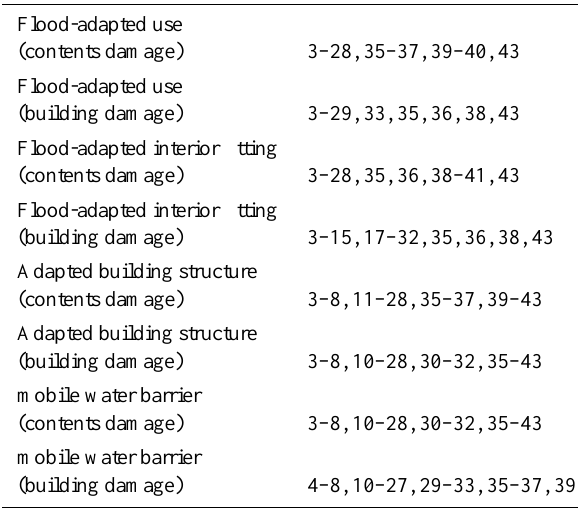
Table A1. Included